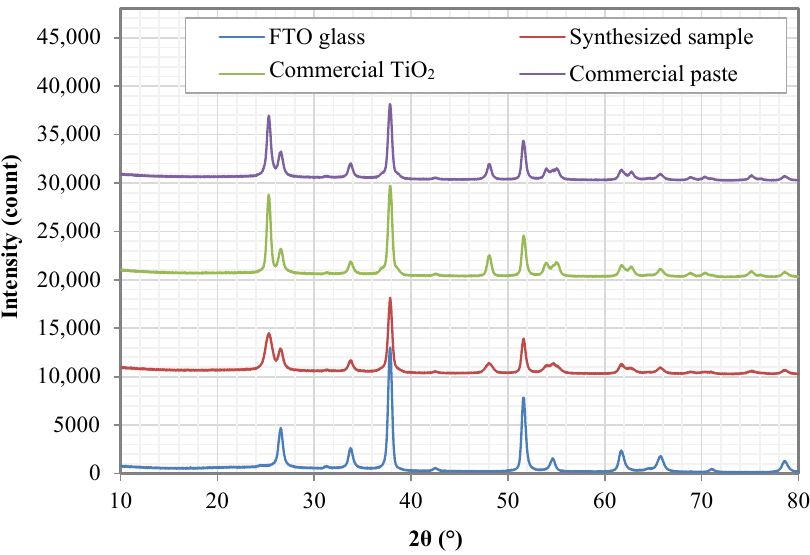
Figure 7. XRD analysis of the FTO substrate, synthesized sample, commercial TiO 2 and the commercial paste.